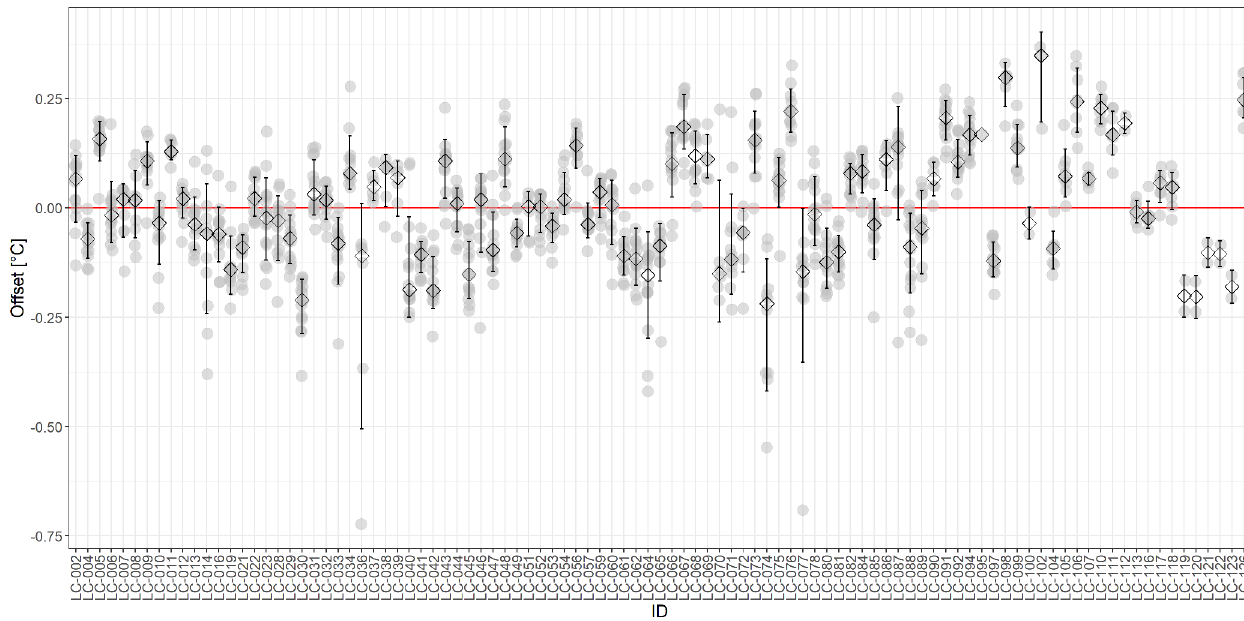
Figure 18. Offsets during the selected episodes (grey dots), the median offset (black diamond) and its error bar (mean ± standard deviation) for each LC-X station active during at least one episode. For reference, the zero line is plotted in